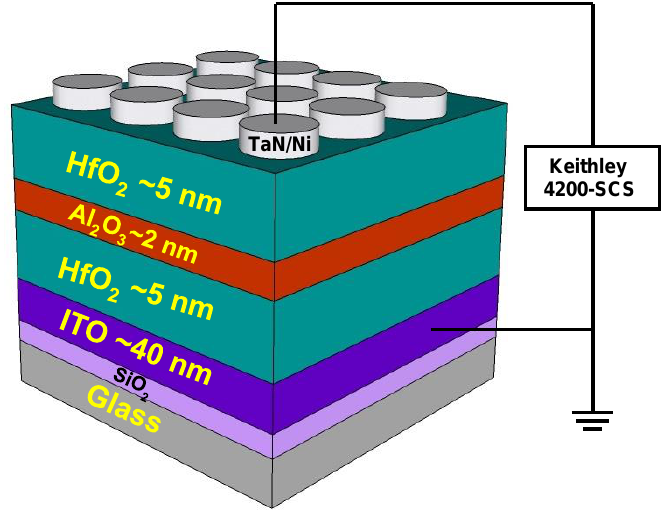
Figure 1. Schematic of TaN/HfO 2 /Al 2 O 3 /HfO 2 /indium tin oxide (ITO) resistive random access memory (RRAM) device structure with top and a bottom electrode connected to Keithley 4200 SCS semiconductor parameter.